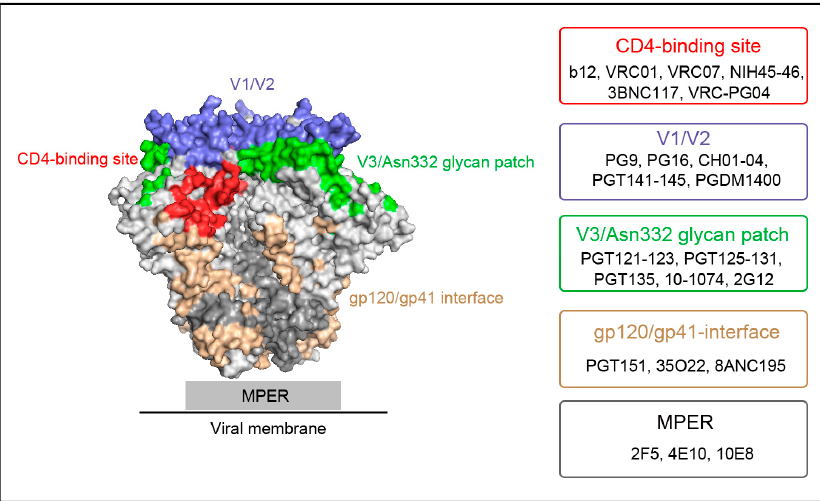
Figure 1. The human immunodeficiency virus type 1 (HIV-1) broadly neutralizing antibodies (bNAbs) epitopes on envelope glycoprotein spike (Env) trimer. The surface representation of Env is derived from the crystal structure of BG505 SOSIP.664 (PDB no. 4TVP). Major HIV-1 Env epitopes are highlighted in different colors (CD4bs (red), V1/V2 (tv-blue), V3/Asn332 glycan patch (green), gp120/gp41-interface (wheat), MPER (denoted as gray rectangle)) and their representative bNAbs are listed in the right boxes. Other unspecified regions are in light grey for gp120 moiety and in dark grey for the gp41 moiety. The structural figure was generated with the program PyMOL (http://www.pymol.org/)